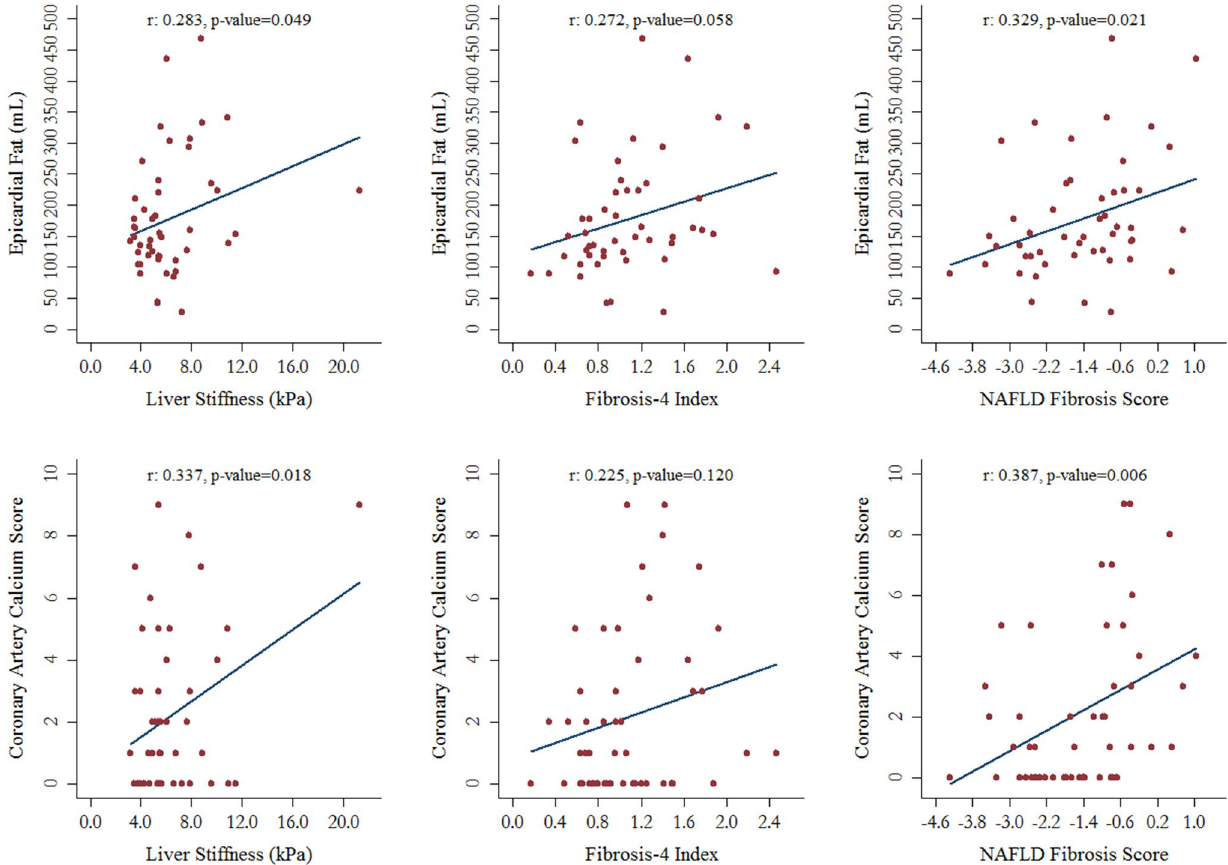
Figure 2. Correlations of liver stiffness and fibrosis serum markers with epicardial fat and coronary artery calcium